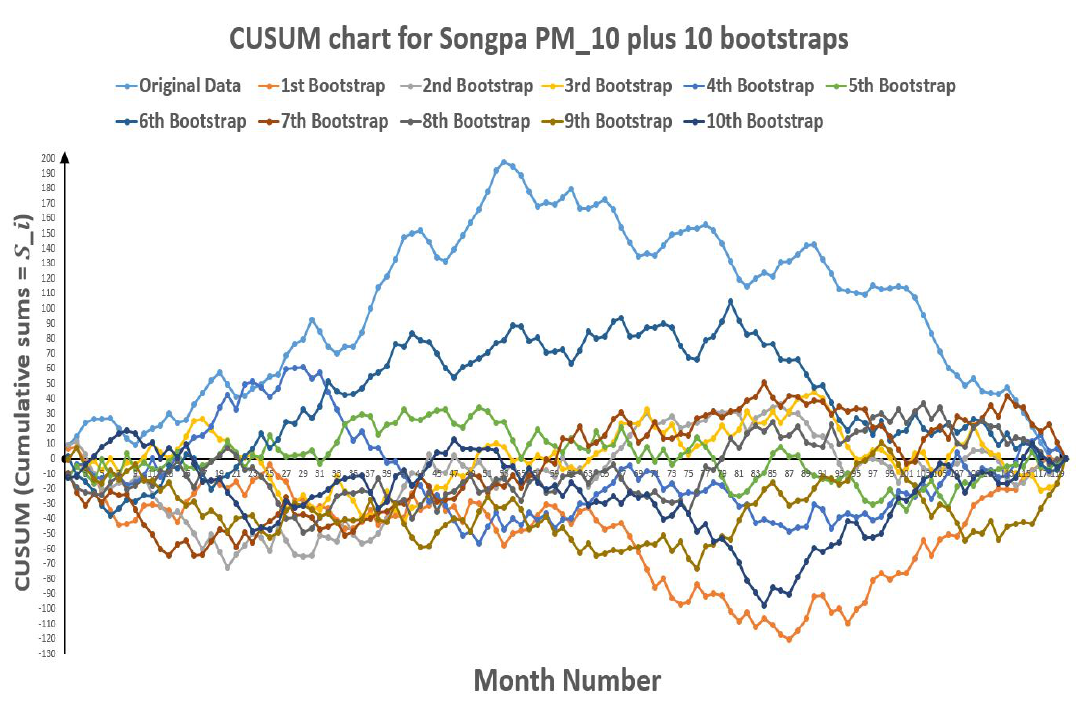
Figure 15. CUSUM chart for Songpa PM 10 plus 10 bootstraps (European